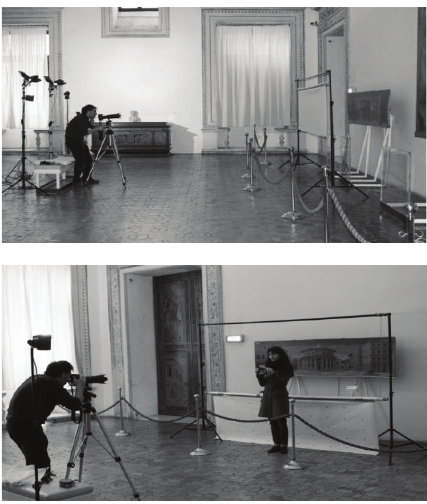
Figure 1: HR acquisition phases and equipment.